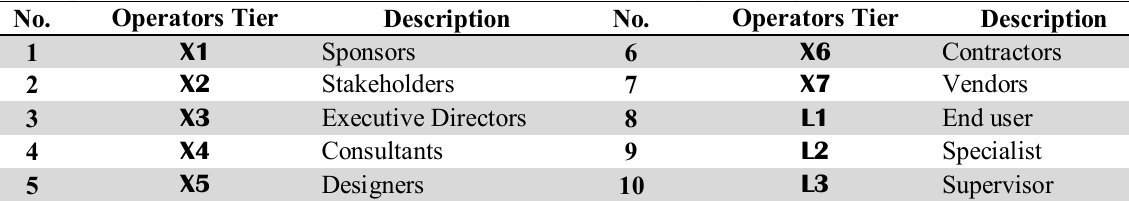
Description of the terms indicated in Operators Tier block diagram (Fig. 3)